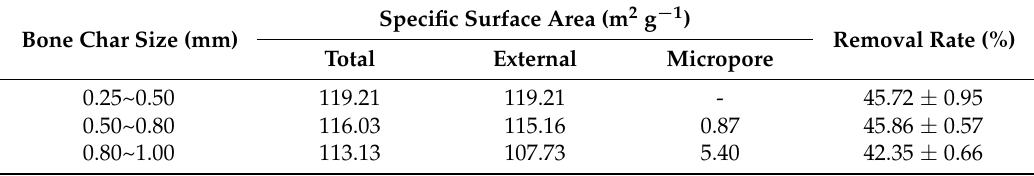
Table 1. Effect of specific surface area on the removal rate of methylene blue by different sizes of bone char ( T : 303 K, t : 24